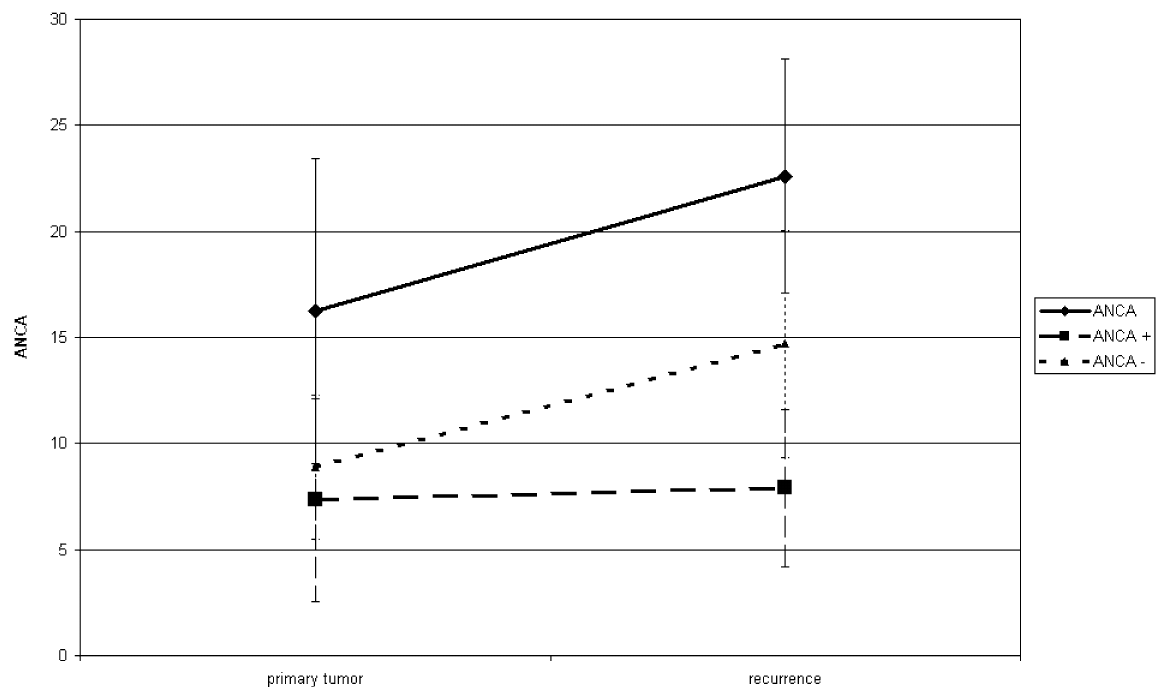
Fig. 3. Averaged number of copy alterations (ANCA) for the comparison of primary tumors and their corresponding local recurrences. The vertical lines represent the standard